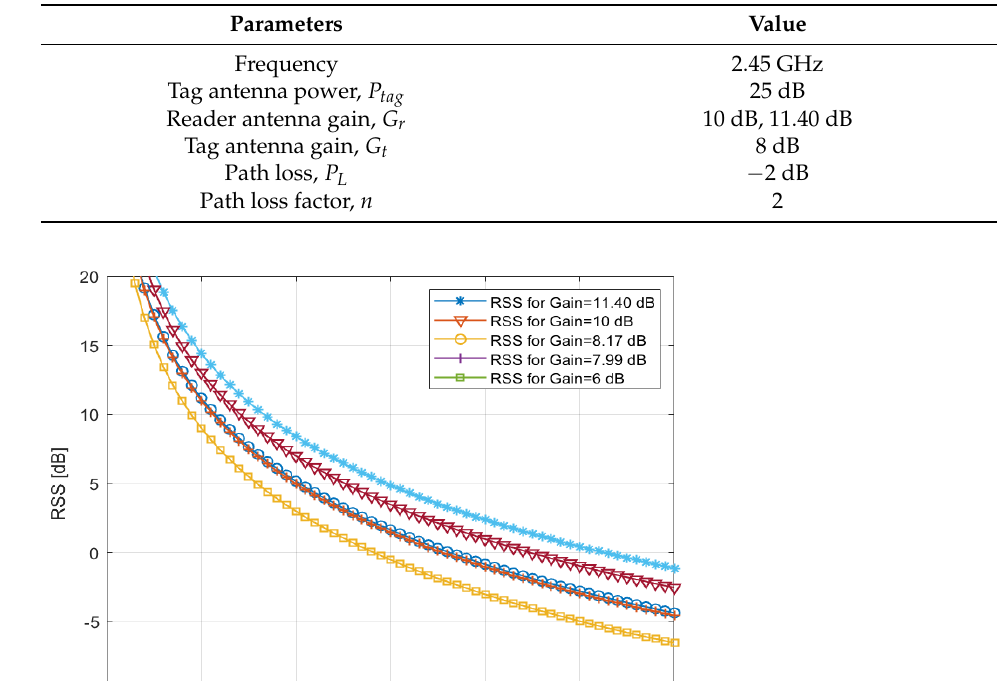
Table 6. Parameters for RSS.